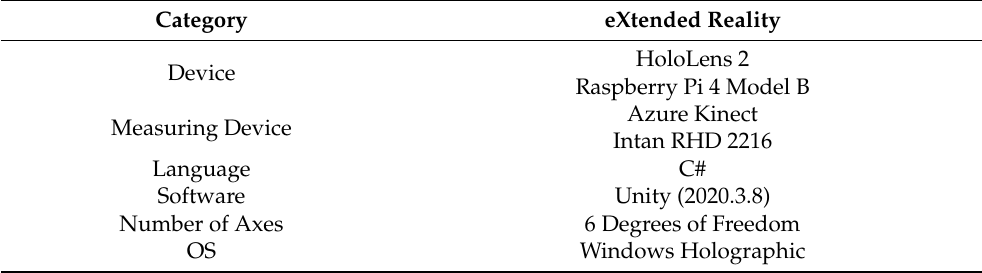
Table 2. Experimental